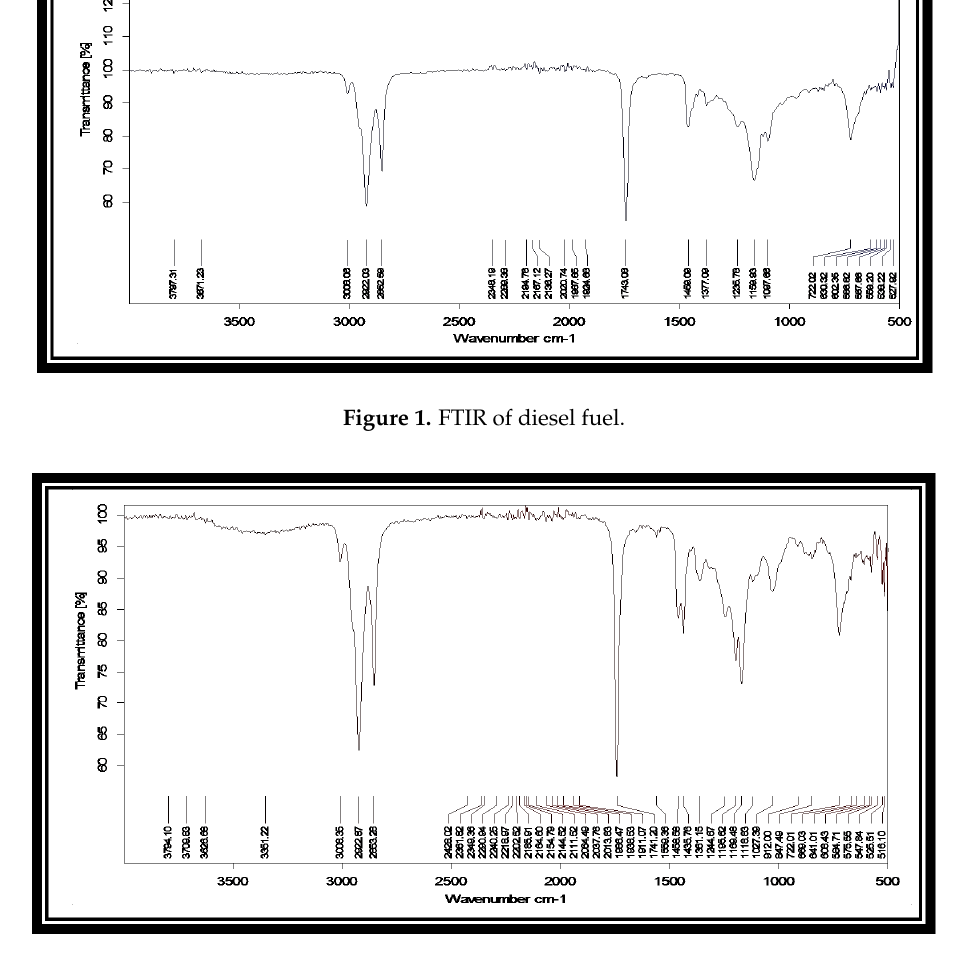
Figure 2. FTIR of BLF. Table 2. FTIR results for diesel and BLF.